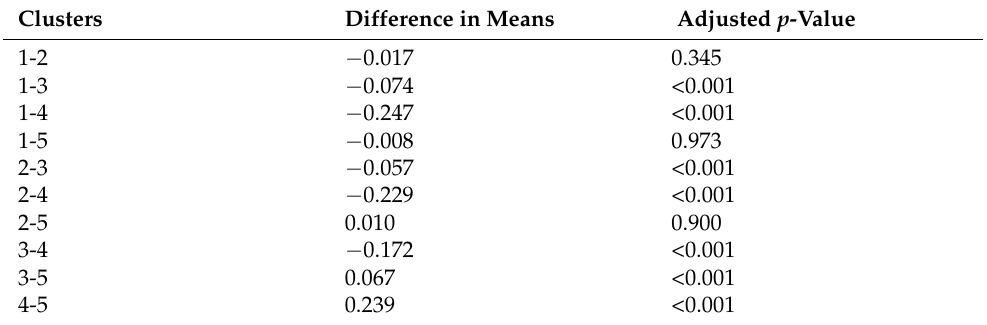
Table A4. Pairwise multiple comparisons using Tukey’s test for the one-way ANOVA in Table A3. Clusters Difference in Means Adjusted p -Value 1-2 − 0.017